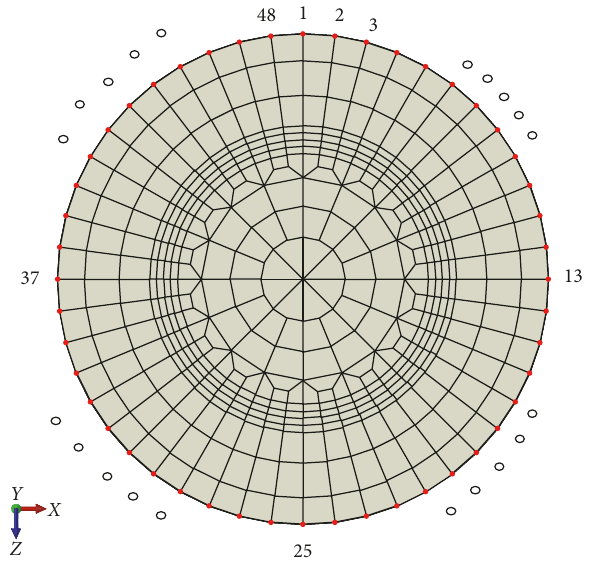
Figure 20: The node number along the outer edge.